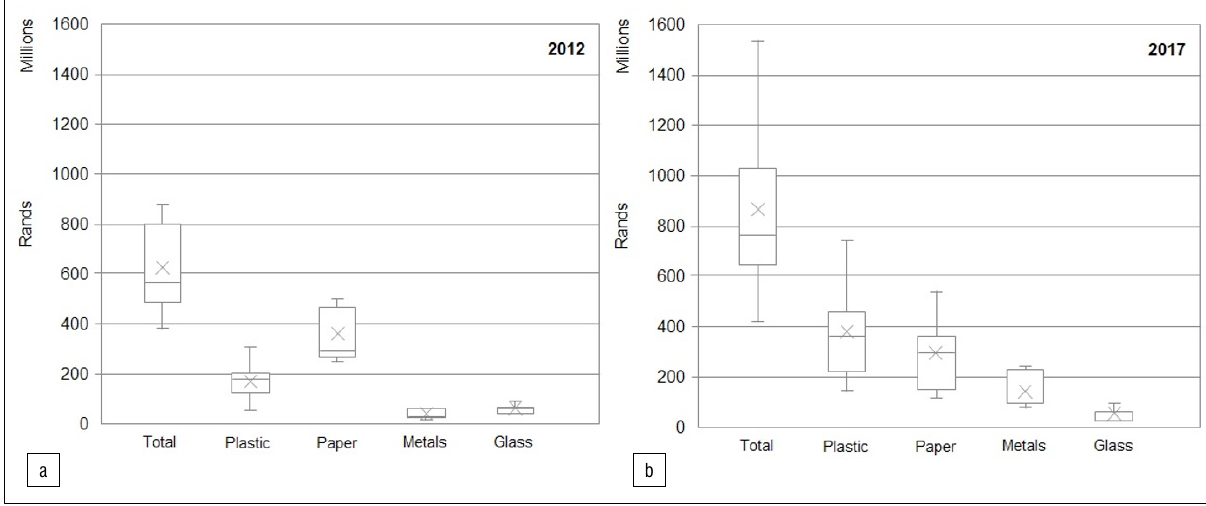
Recyclable waste type